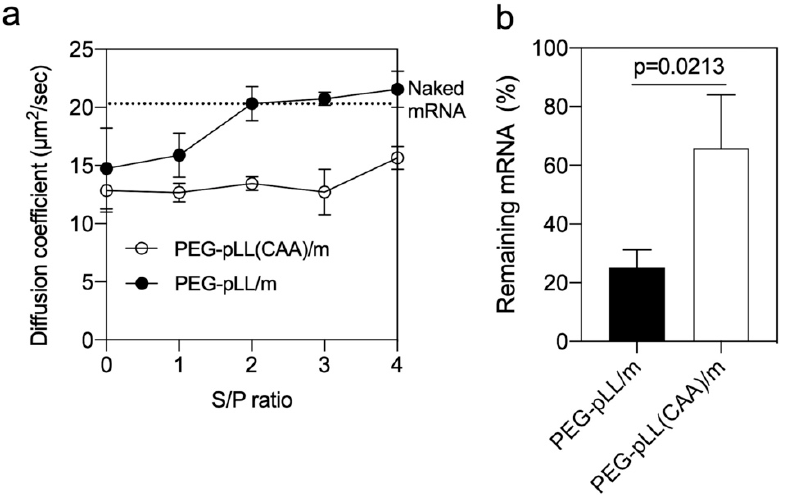
Figure 2. Stability of micelle. ( a ) Diffusion coefficient of micelles after incubation with sodium dextran sulfate at different S/P (sulfate in dextran sulfate/phosphate in mRNA) ratios for 1 h. The upper dashed line represents the diffusion coefficient of naked mRNA. Data were expressed as the mean ± s.d. ( n = 10). ( b ) Remaining mRNA after incubating micelles with serum at 37 °C for 15 min. The mRNA amount was measured by qRT-PCR. Data were expressed as the mean ± s.d. ( n = 3). p -value was calculated by the two-tailed Student’s t -test.